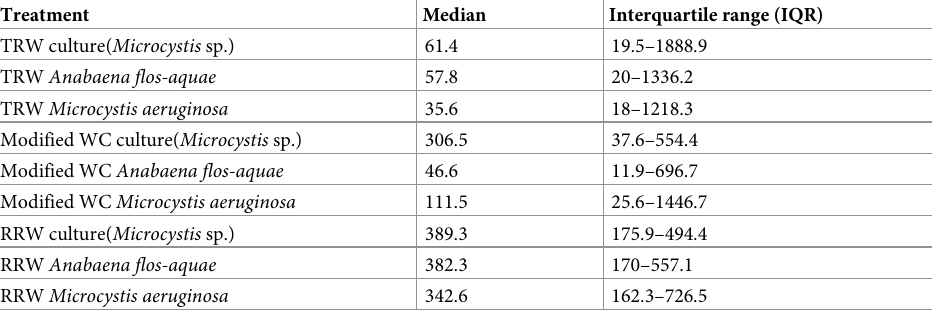
Table 1. Variations in chlorophyll-a ( μ g L -1 ) levels among experimental treatments.